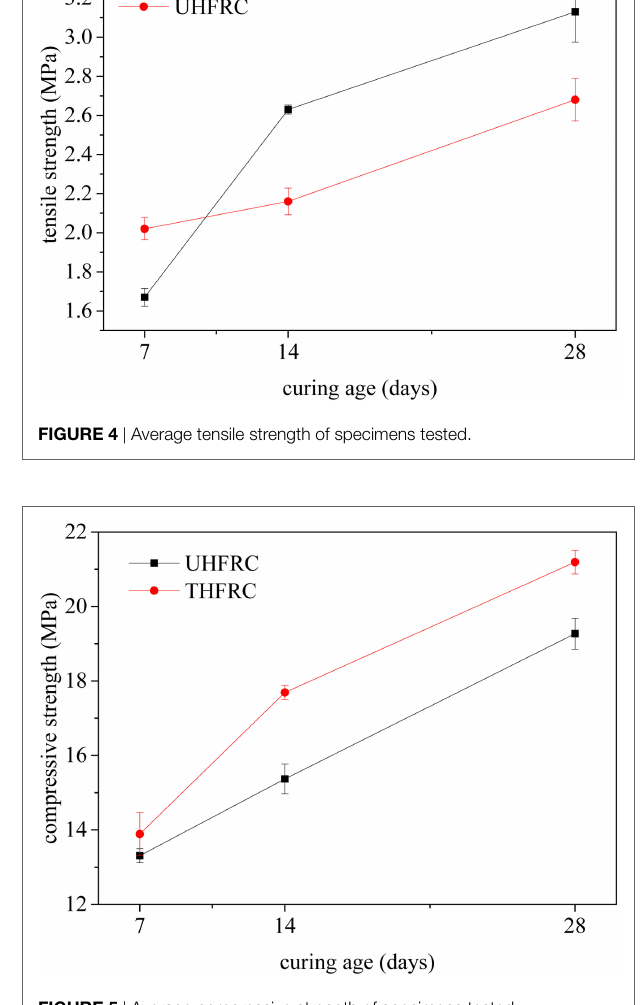
FIGURE 5 | Average compressive strength of specimens